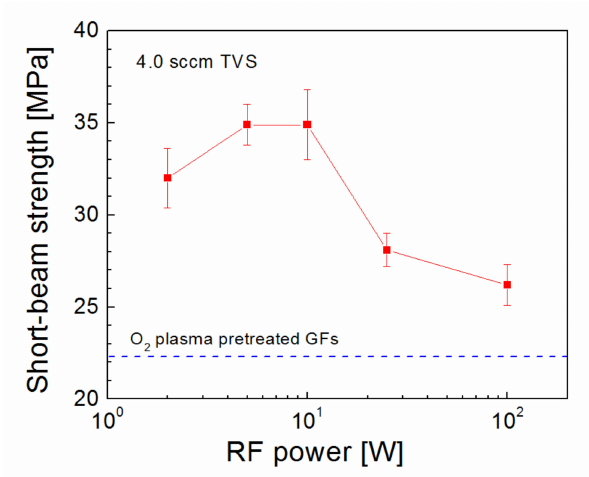
Figure 13. Short-beam strength of GF / polyester composites dependent on RF power used for plasma-coated GFs from pure TVS precursor compared to the shear strength corresponding to oxygen-plasma pretreated